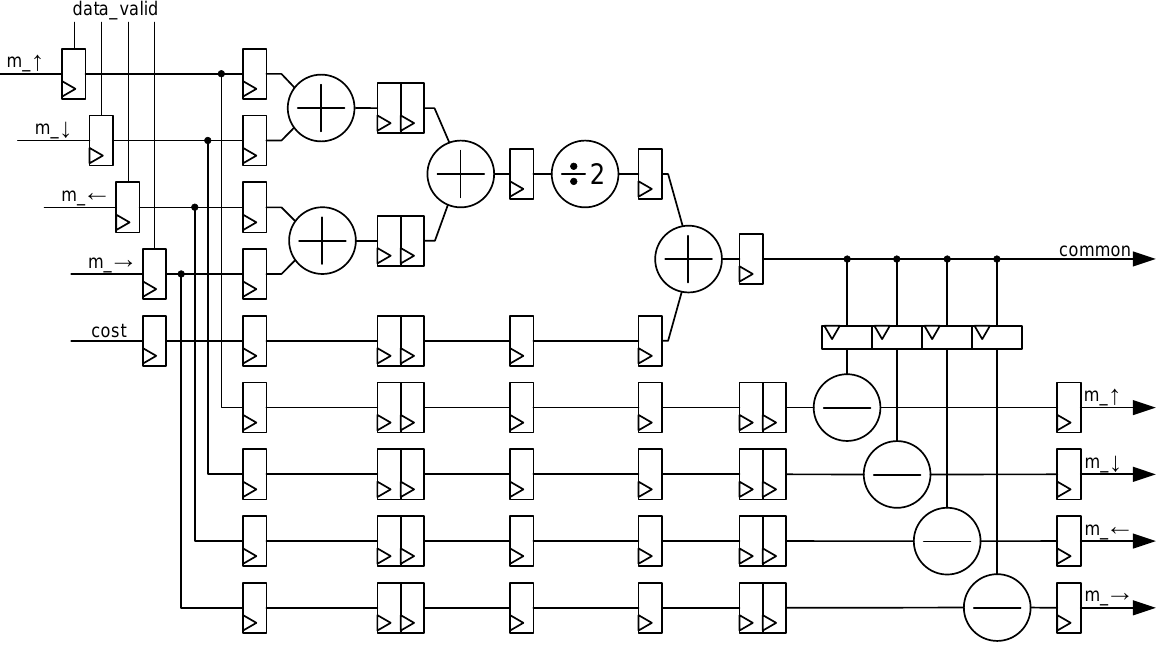
Figure 6. Architectural block diagram of the arithmetic